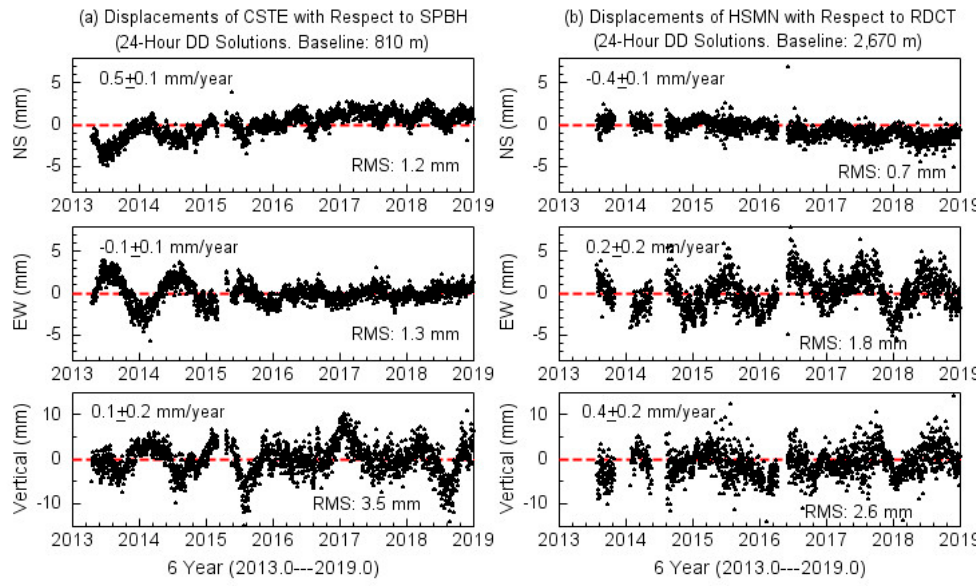
Figure 9. (a) The three-component displacement time series of the hangingwall station CSTE with respect to the footwall station SPBH; (b) the three-component displacement time series of the hangingwall station HSMN with respect to the footwall station RDCT.